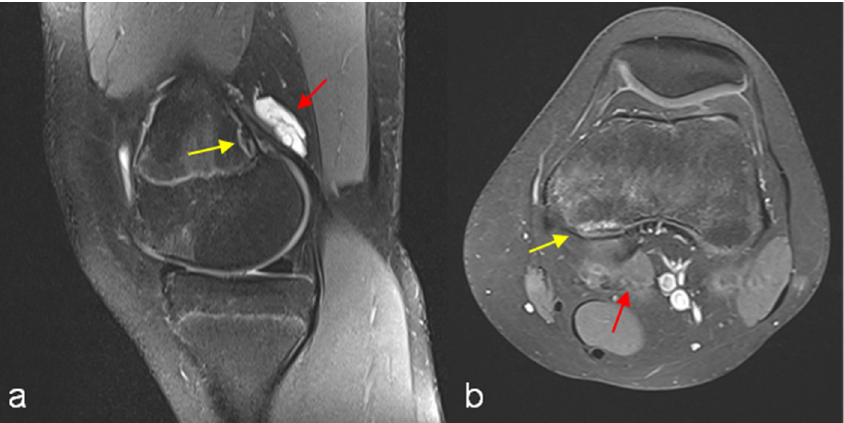
Figure 1. MRI left knee PD TSE FS sagittal reconstruction ( a ) and T1 TSE FS (Gd contrast agent) transversal reconstruction ( b ). Cystic fluid-filled lesion above the femoral origin of the medial gastrocnemius head with marginal Gd enhancement (red arrows), discrete signal enhancement at the tendinous insertion site. Cortical irregularity (DFCI) with signal enhancement and low-signal marginal sclerosis (yellow arrows).